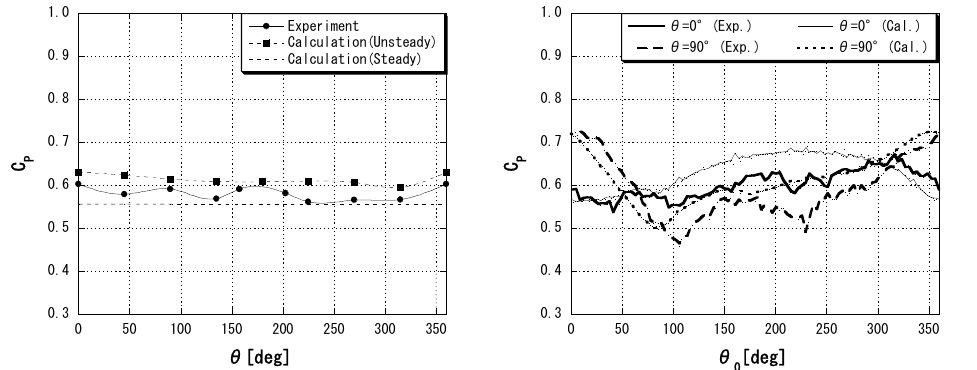
Fig. 7 C P distributions in time average ( φ =0.025) Fig. 8 C P distributions ( φ